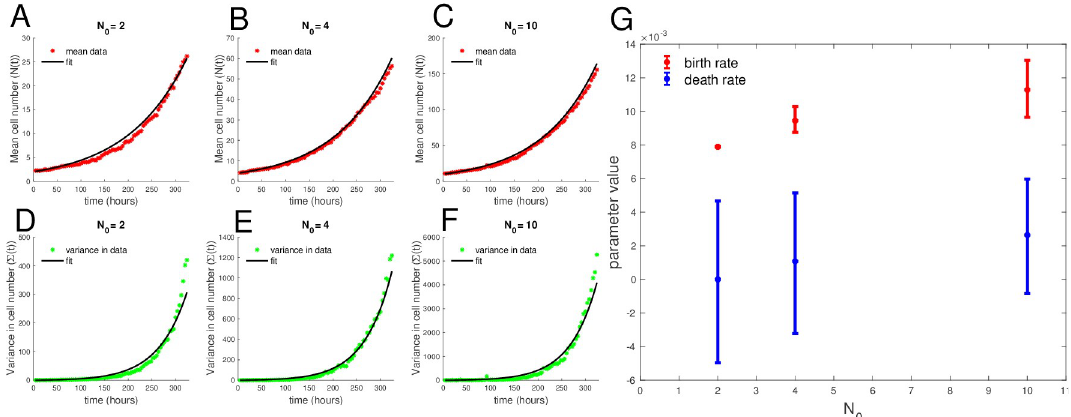
Fig 7. Best fit of each initial cell-number means and variances in time to stochastic birth–death model reveals net growth rate increases with initial cell number. (A, B, and C) Data mean over time compared to best fit to model mean. (D, E, and F) Data variance in time compared to best fit to model variance. (G) Best fit birth and death rate parameters for the stochastic birth–death model fit to each initial condition, with confidence intervals determined from profile likelihoods. Parameter estimates for birth rates by initial cell number are b 2 = 0.00793 [0.00785 − 0.00794], b 4 = 0.00945 [0.0093 − 0.0096], and b 10 = 0.0113 [0.0112 − 0.0114], and for death rates, the parameter estimates are d 2 = 6.67 × 10 − 18 [ − 0.0005 to 0.0001], d 4 = 0.0011 [0.0008 − 0.0013], and d 10 = 0.00286 [0.0025 − 0.0028] for N 0 = 2, 4, and 10, respectively. The data and code used to generate this figure can be found at https://github.com/ brocklab/Johnson-AlleeGrowthModel.git.